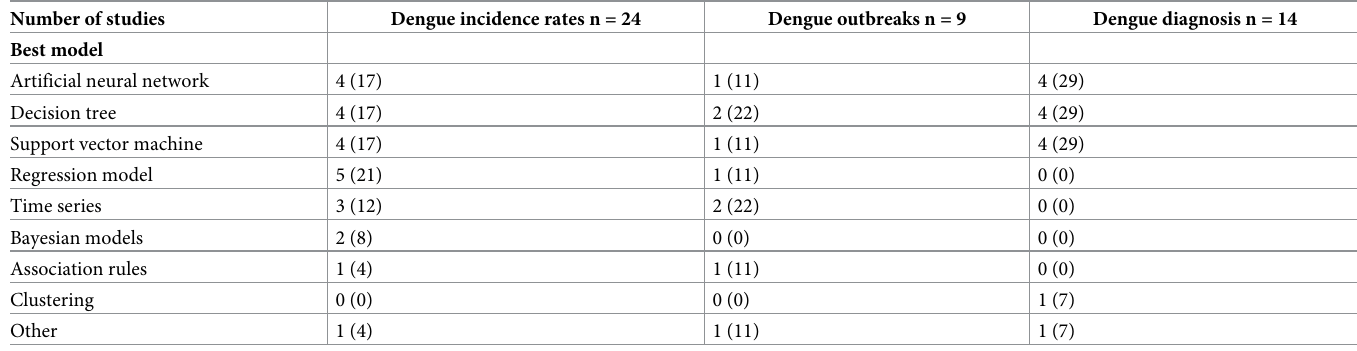
Table 6. Model with the best performance for the three most frequently studied